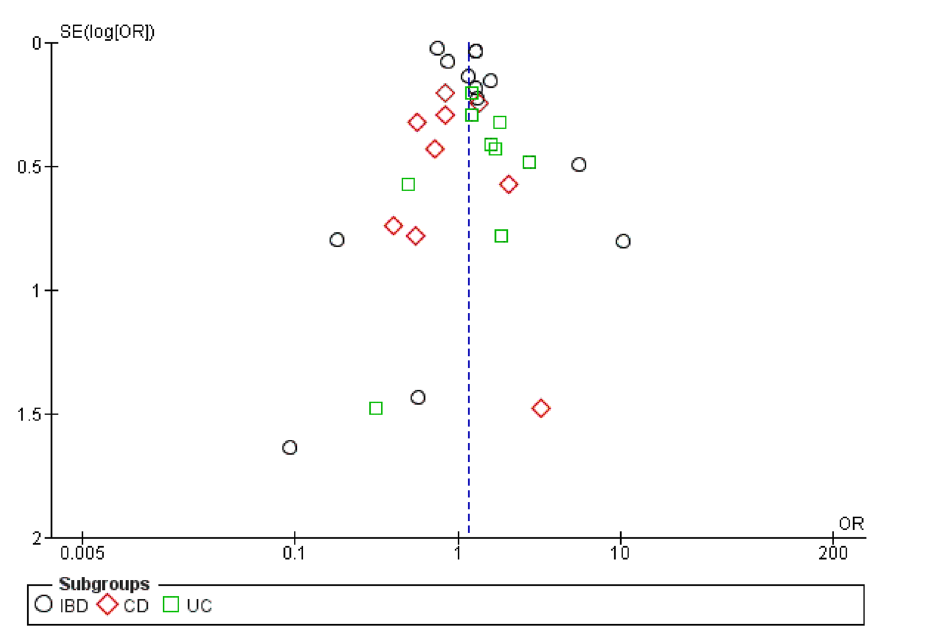
Figure 10. Funnel plot for the risk of COVID-19 outcomes in IBD